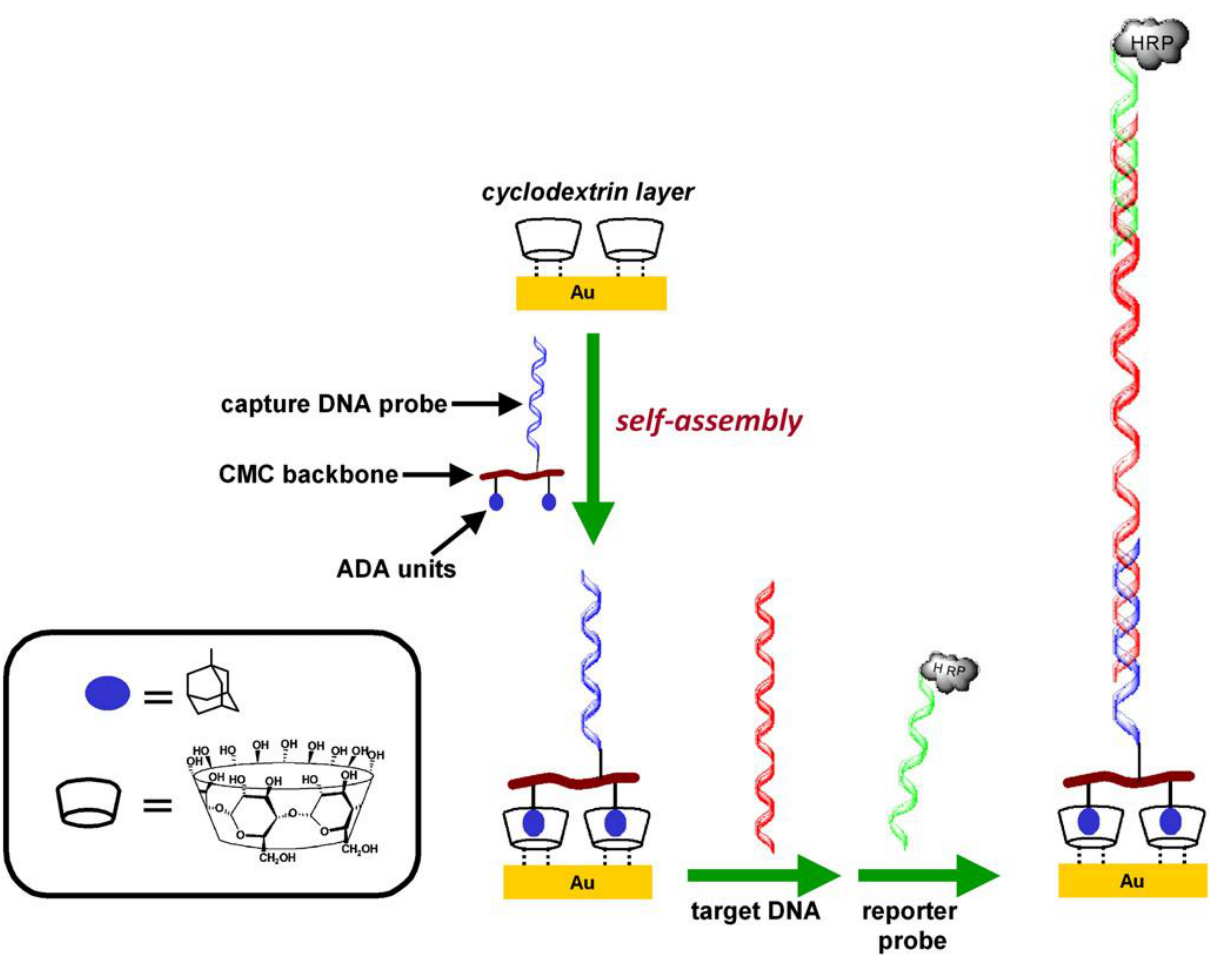
Figure 5. Genosensor fabrication based on host-guest complexation on an electrode surface. Reprinted with permission from O’Sullivan et al . [68]. Copyright 2011